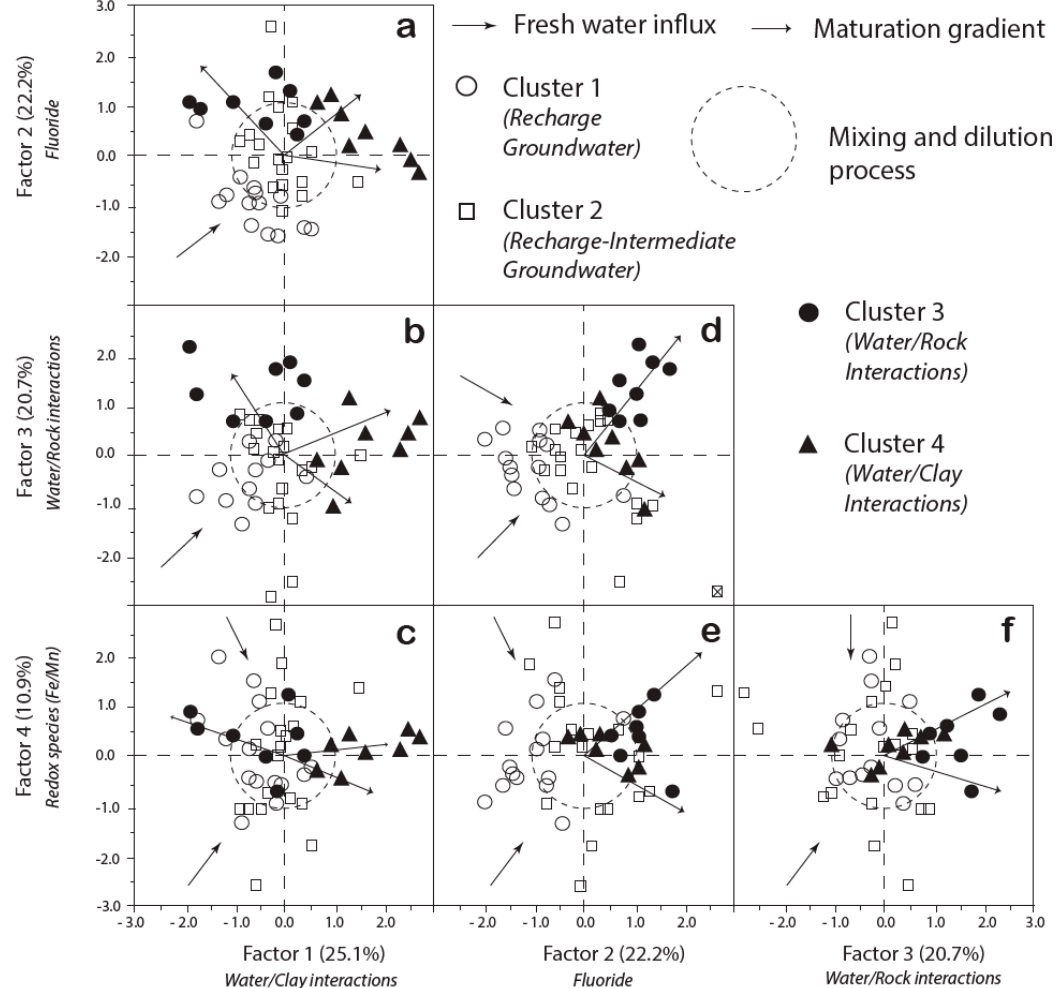
Figure 11. Graphical representation of the sample scores calculated for each of the factors obtained during the factorial analysis procedure. The different combinations of factors led to the construction of six binary diagrams: ( a ) Factor 1 vs. Factor 2; ( b ) Factor 1 vs. Factor 3; ( c ) Factor 1 vs. Factor 4; ( d ) Factor 2 vs. Factor 3; ( e ) Factor 2 vs. Factor 4; and ( f ) Factor 3 vs. Factor 4. Samples are represented with symbols corresponding to the cluster number of the samples for the subset. Mixing and dilution zones defined in the center of the binary diagrams contain samples that are weakly influenced by the factors (scores < 1). Two series of vectors represent the evolution of groundwater: one set of vectors represents the evolution of the recharge groundwater (fresh water influx), and the second set of vectors corresponds to the evolution of groundwater from the mixing and dilution zones toward the brackish groundwater (maturation gradient).